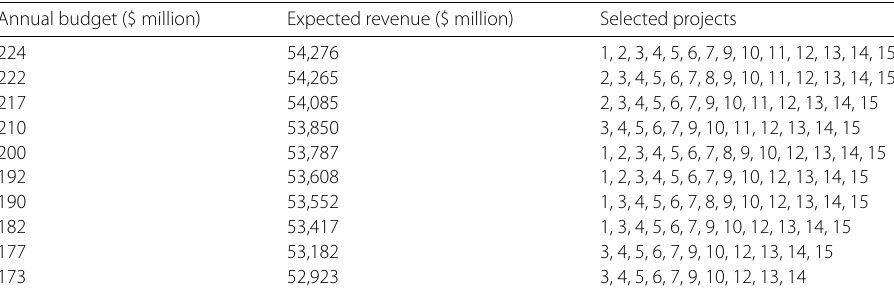
Table 4 Optimal project